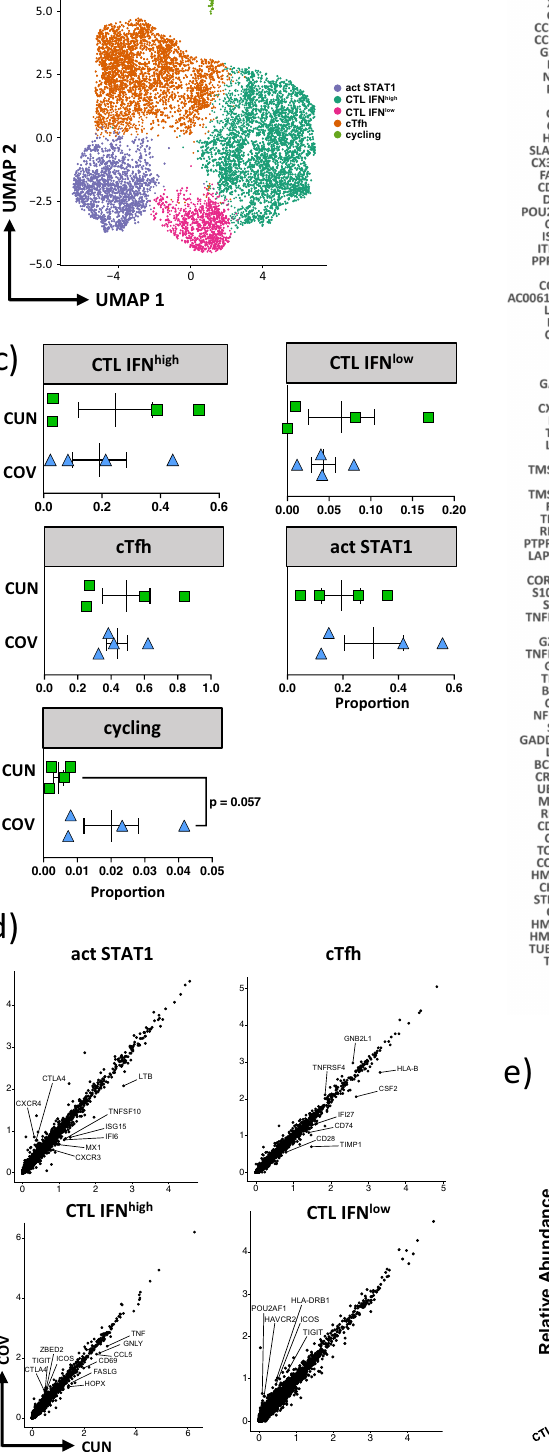
a relative increase in the frequency of memory T lymphocytes 52 . Previous data suggest that aging and scarcity of naïve T cells may be risk factors for failure to generate a coordinated adaptive immune response, resulting in increased susceptibility to COVID-19 53 . We found that COV patients display lower per- centages of CM CD4 + T cells, but they express higher levels of